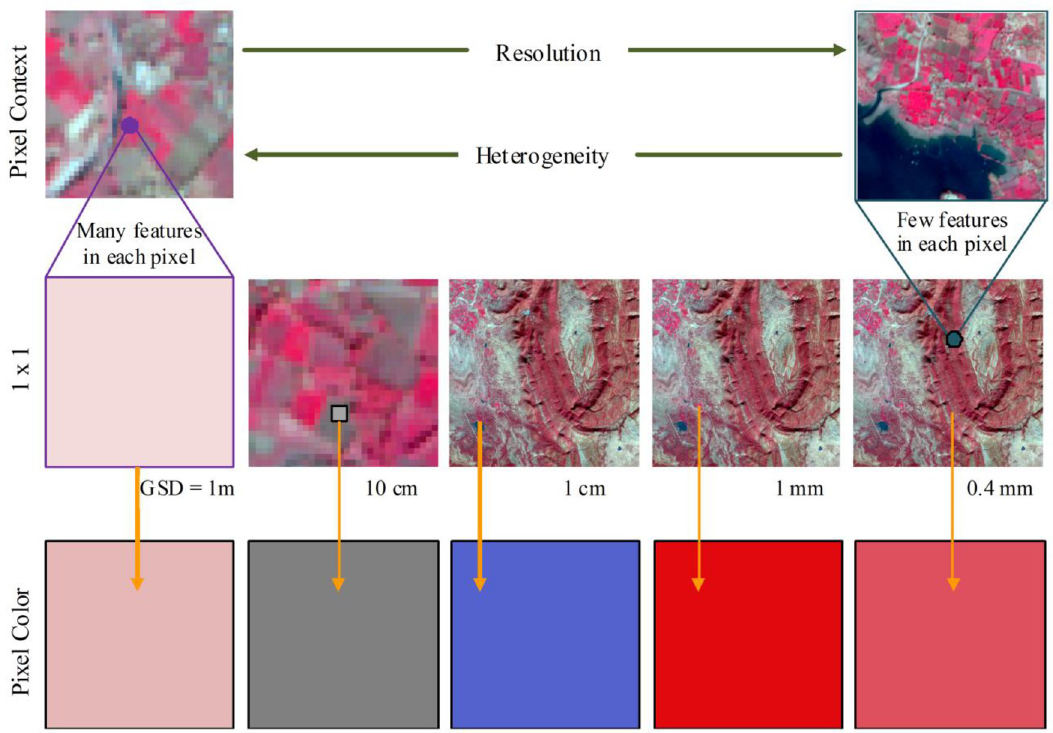
Fig 4. Effect of spatial resolution on visual interpretation of the Image. (Source: https://www.usgs.gov/centers/eros).